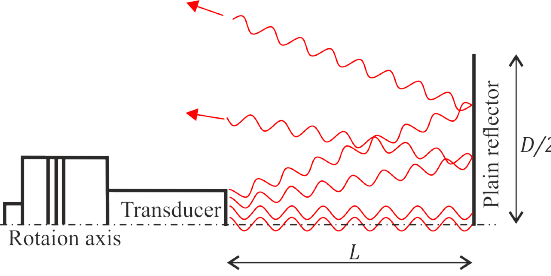
Figure 1. Sound wave propagation directions at a standing wave system with plain